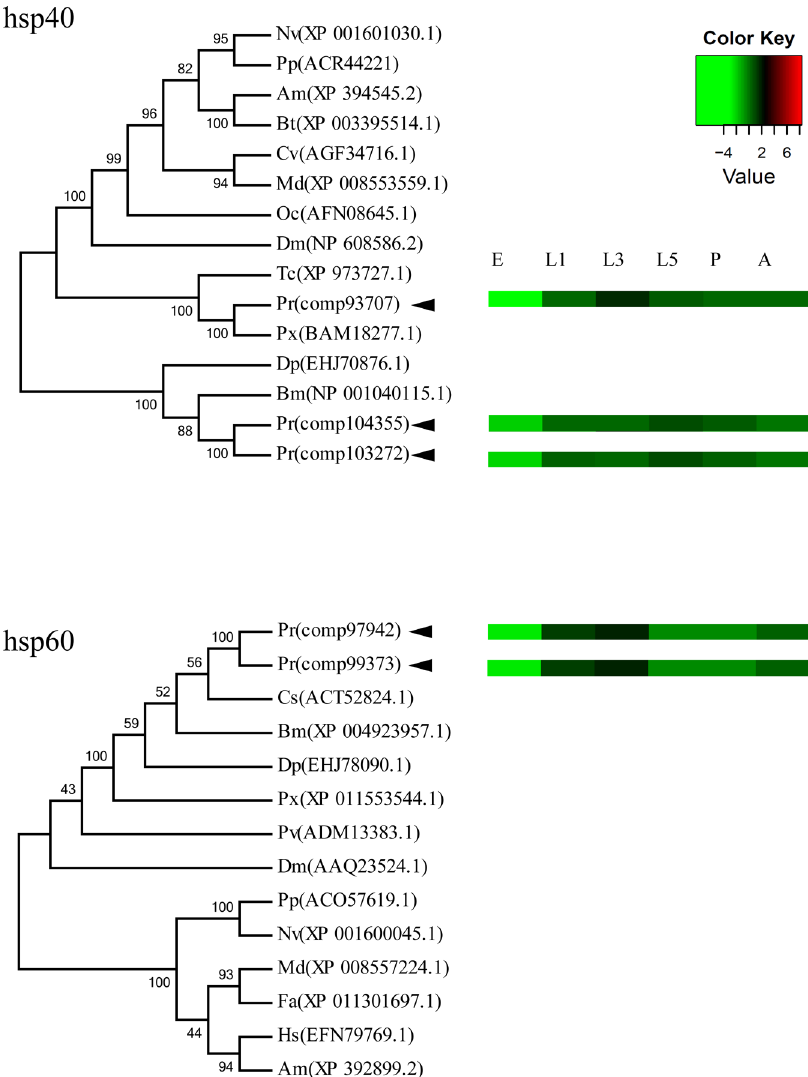
Fig 6. The homology relationships of Pieris rapae heat shcok proteins with their counterparts in other insect species as well as expression levels in P . rapae during development. The trees were generated using the NJ method in Mega5 software. Expression levels were compared with their RPKM values. The other Hsp amino acid sequences used are from Nv ( Nasonia vitripen nis), Am ( Apis mellifera ), Bt ( Bombus terrestris ), Cv ( Cotesia vestalis ), Md ( Microplitis demolitor ), Oc ( Oxya chinensis ), Dm ( Drosophila melanogaster ), Tc ( Tribolium castaneum ), Pr ( Pieris rapae ), Px ( Papilio xuthus ), Dp ( Danaus plexippus ), Bm ( Bombyx mori ), Cs ( Chilo suppressalis ), Pv ( Polypedilum vanderplanki ), Fa ( Fopius arisanus ), and Hs ( Harpegnathos saltator ).